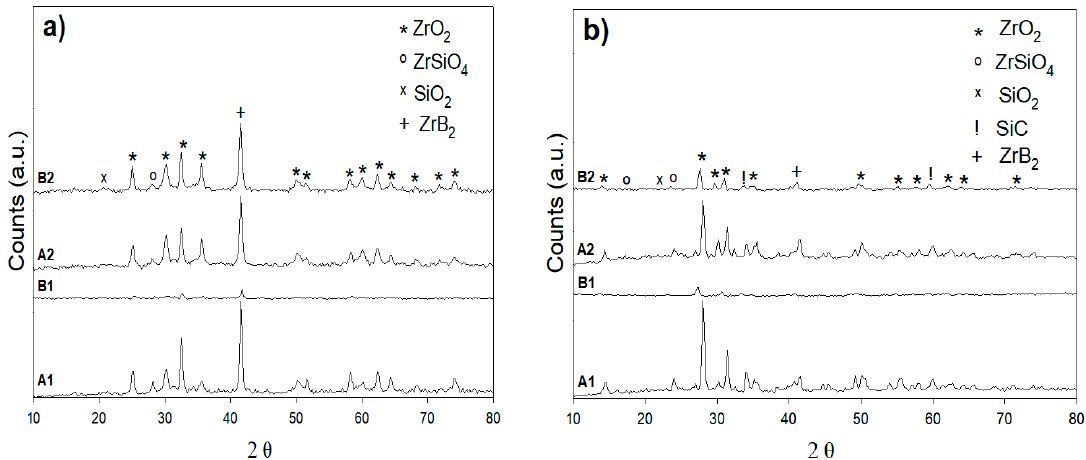
Figure 11. XRD patterns of the surface oxidation of A1, B1, A2 and B2 of ( a ) torch treatment for 5 min at 1200 °C and ( b ) furnace treatment for 30 min at 1200 °C.